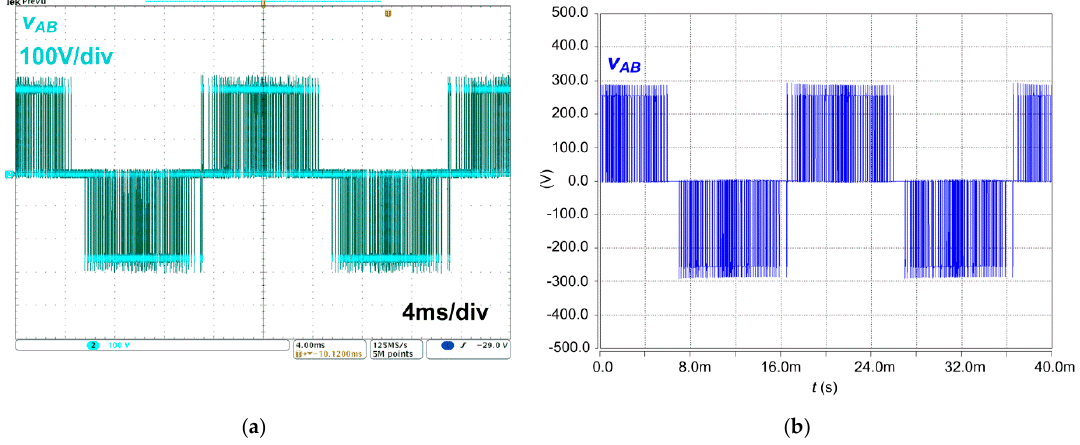
Figure 15. Line -to-line voltage v AB : ( a ) measurement; ( b ) simulation.